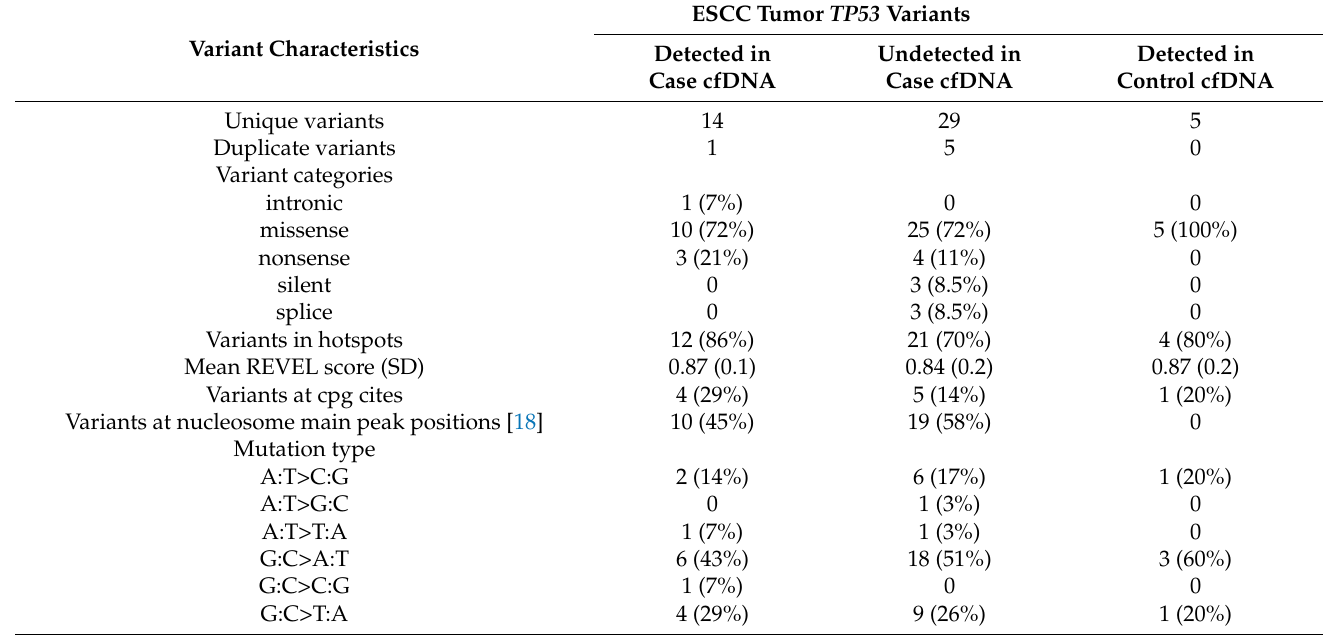
Table 3. Characteristics of tumor TP53 variants according to detectability of variants in cfDNA cases and controls.